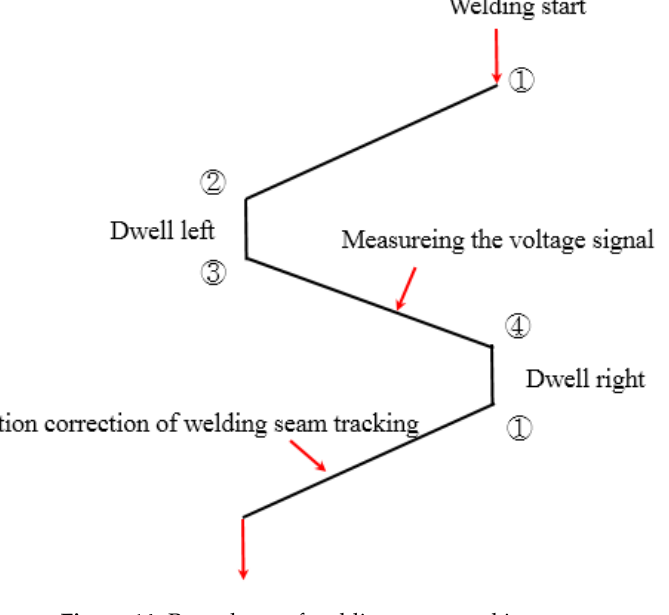
Figure 14. Procedures of welding seam tracking. Table 1. Function of the control module in welding seam tracking.